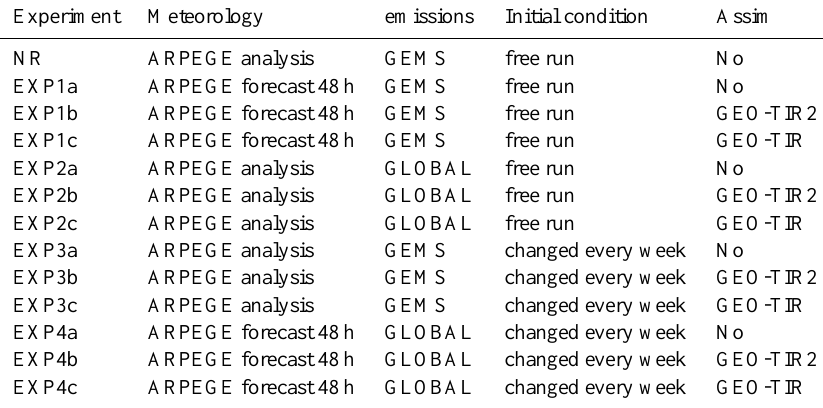
Table 3. Description of the different experiments. The NR experiment represents the nature run or the true atmosphere. The experiments with a change in the meteorology, emissions and initial condition are referred as EXP1, EXP2 and EXP3, respectively. The experiments with a change in the meteorology and emission and initial condition are referred as EXP4. The (a), (b) and (c) extensions represent the experiments with no assimilation, with assimilation of GEO-TIR2 and with assimilation of GEO-TIR, respectively. See text for further details. Experiment GEMS